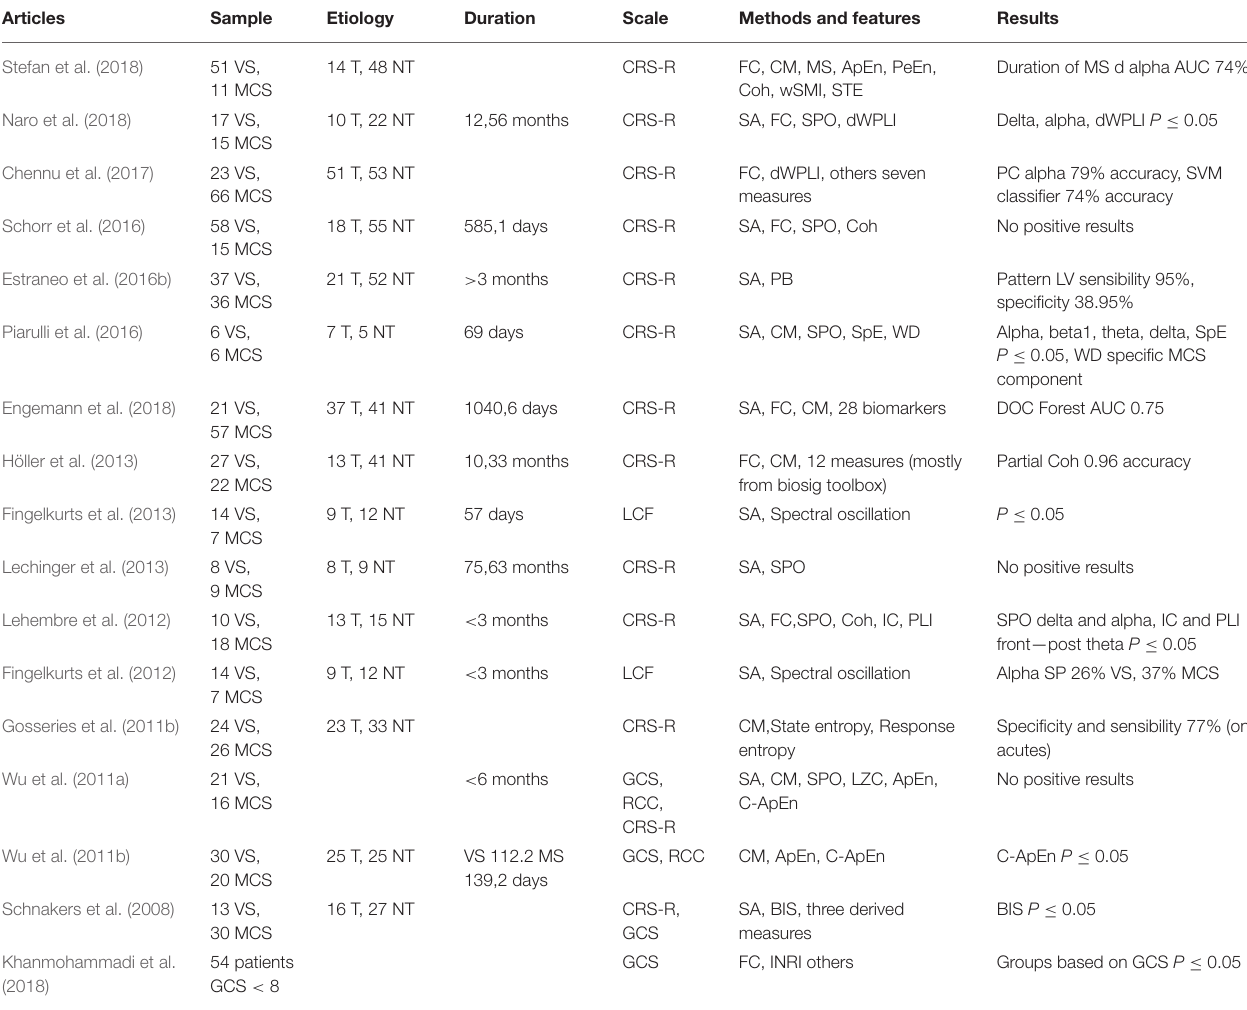
TABLE 1 | Studies characteristics and results.